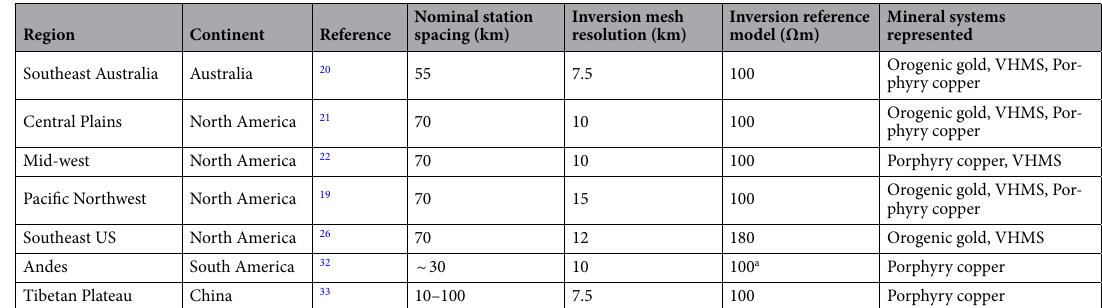
Table 1. Key details of resistivity models used in the statistical analysis presented in the paper. a 100 Ωm halfspace with a 1000 Ωm predefined subducting